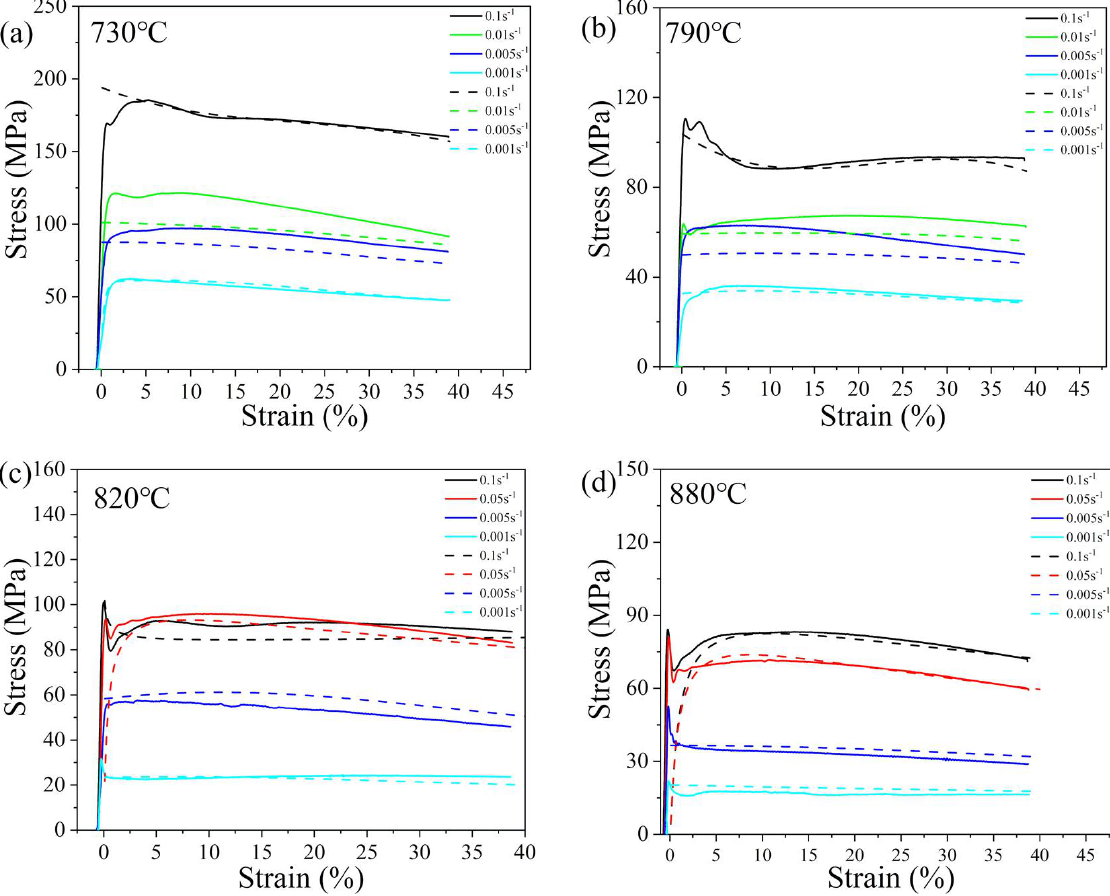
Figure 9. Contrast between experimental flow stress (solid line) and predicted flow stress (dot line):